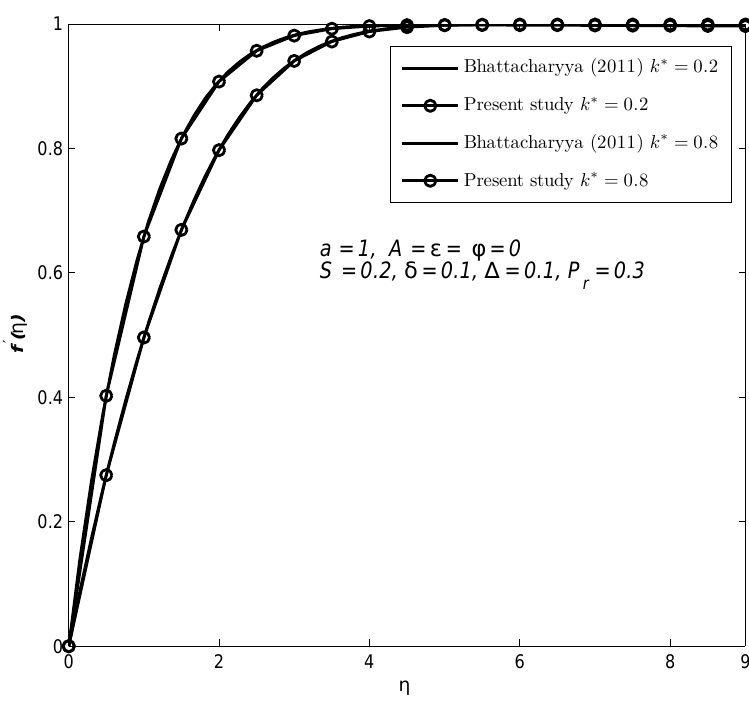
Figure 2. Comparison of the results for the velocity f (cid:48) ( η ) profiles for different values of permeability parameter k ∗ , with Bhattachaaya et al. [43].